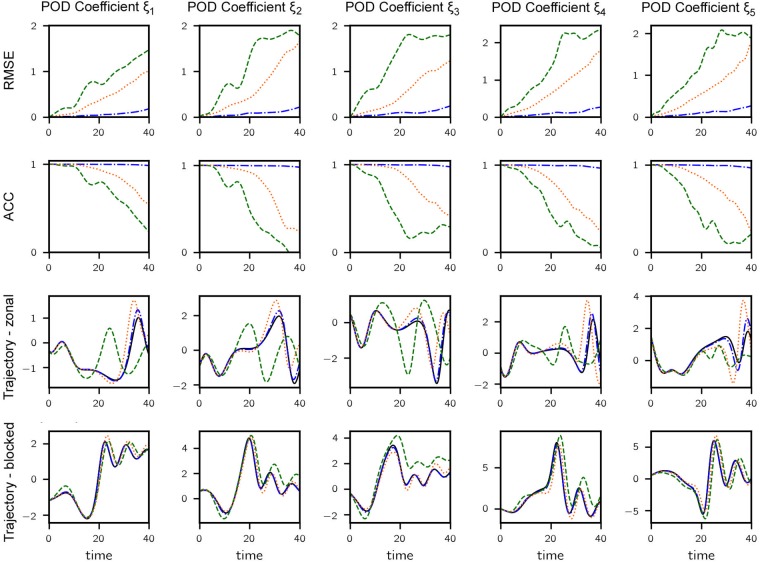
Results for CDV system.(Row 1) RMSE vs. lead time for 5-mode POD projected model (orange dotted), data-assisted model (blue dashdotted) and purely data-driven model (green dashed). (Row 2) ACC vs. lead time. (Row 3) A sample trajectory corresponding to zonal flow—true trajectory is shown (black solid). (Row 4) A sample trajectory involving regime transition (happening around t = 20). For rows 1, 3 and 4, plotted values are normalized by the standard deviation of each dimension.